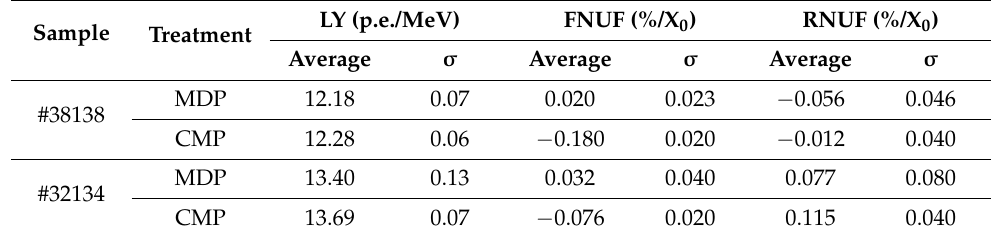
Table 3. The optical results obtained from measurements on samples submitted to the Mechanical Diamond Polishing (MDP) and Chemical Mechanical Polishing (CMP) surface finishing. Average values and corresponding standard deviation ( σ ) are reported. LY = Light Yield, FNUF = Front Non-UniFormity, RNUF = Rear